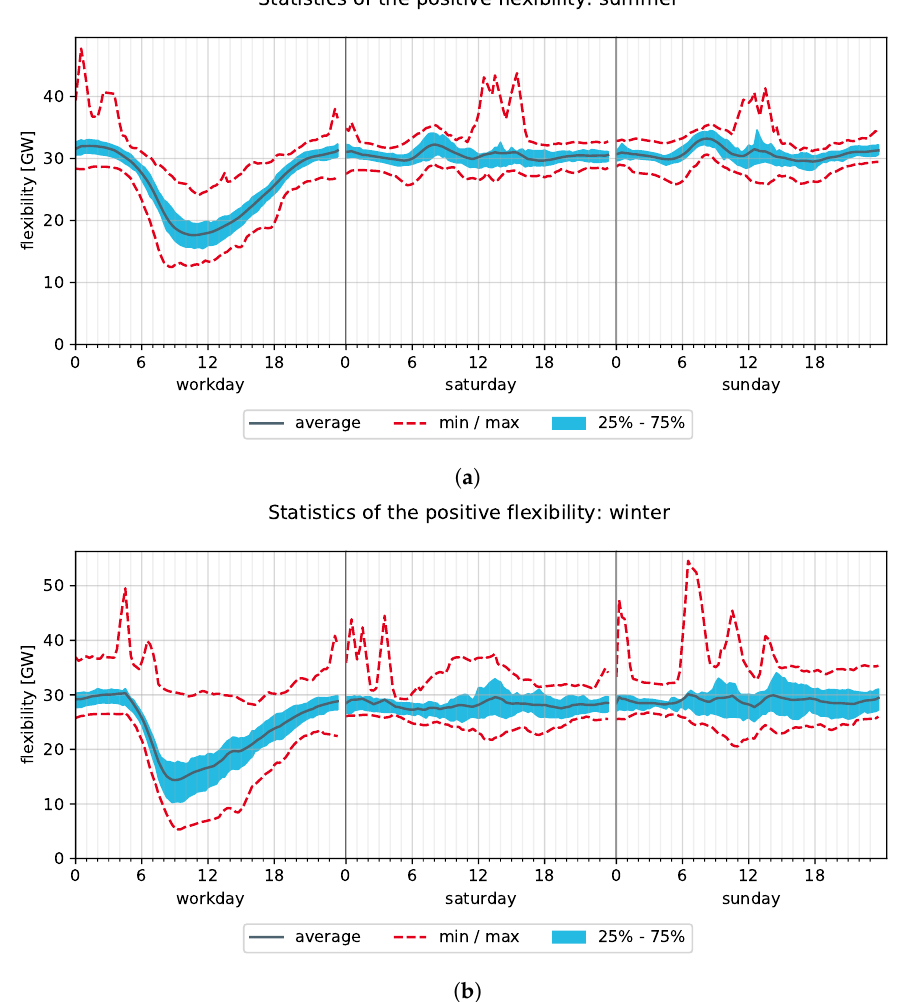
Figure 10. Daily variation in the immediately available positive flexibility in the ( a ) summer and ( b ) winter of the year